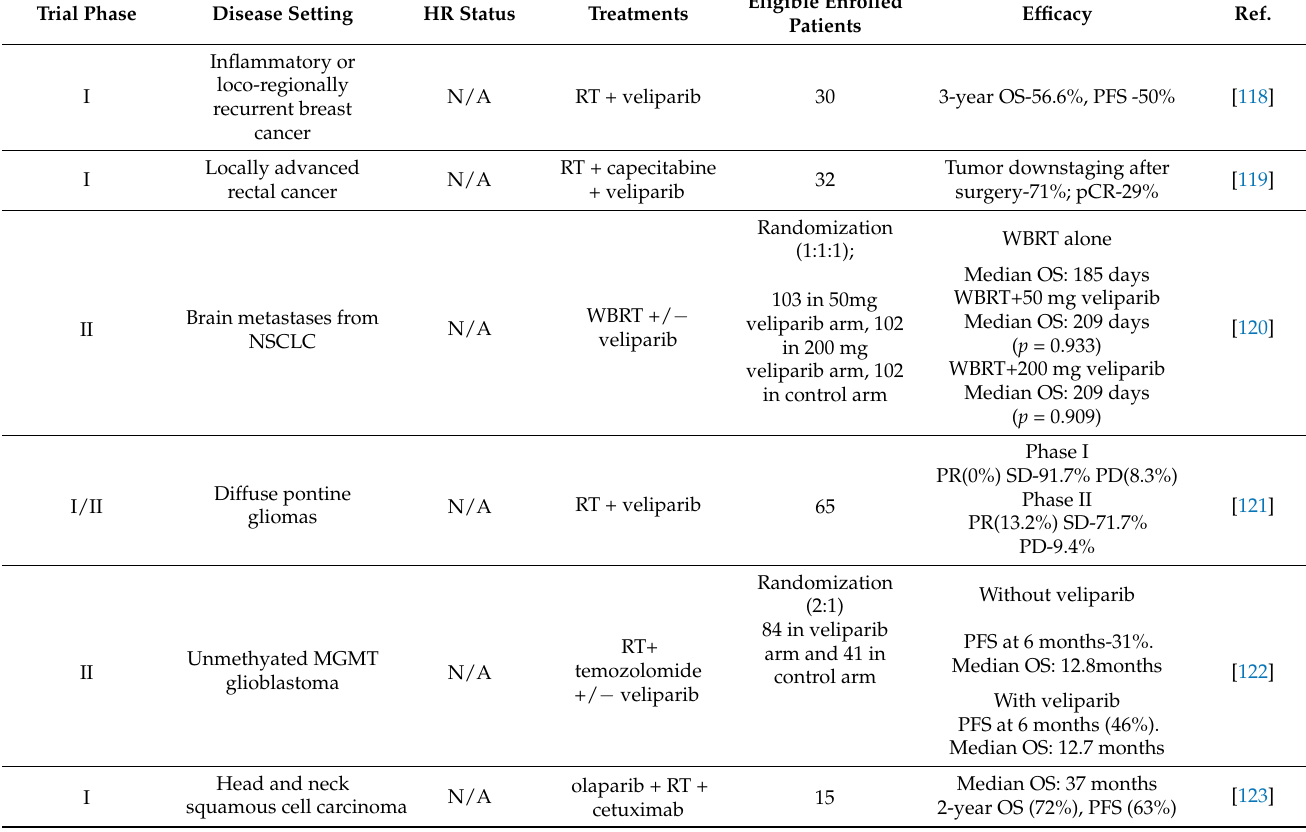
Table 1. Published Clinical Studies on PARPi combined with